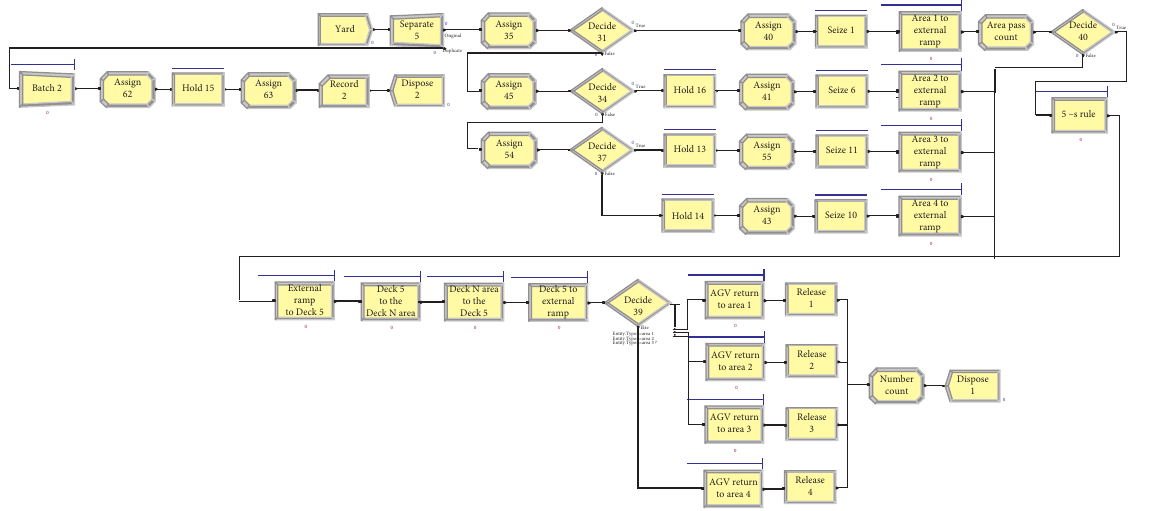
Figure 3: Simulation model of the AGV loading system in Arena (source: